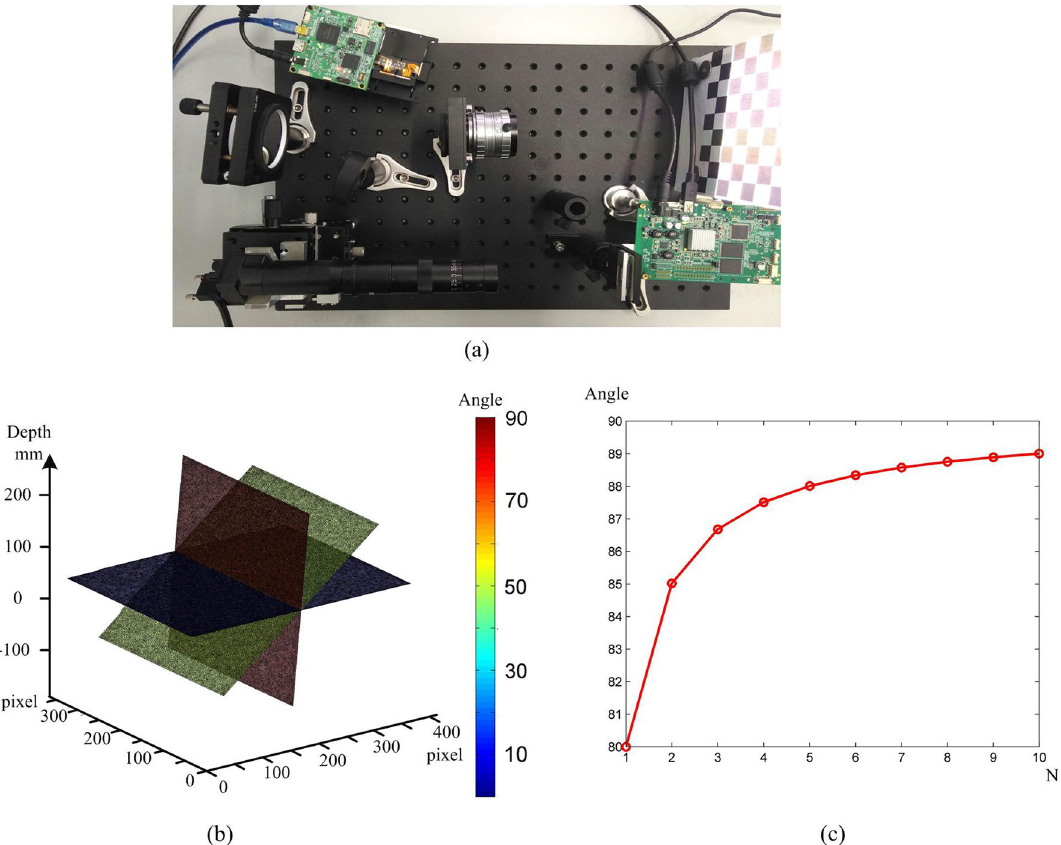
Figure 5. The experimental results of measuring planes with various angles. ( a ) The experimental setup. ( b ) 3D reconstructed planes with various angles. ( c ) Maximum measurable angle with different parameter N.